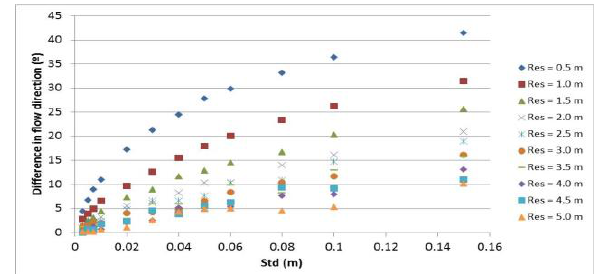
Figure 14. Difference in flow direction versus standard deviation of Gaussian noise.